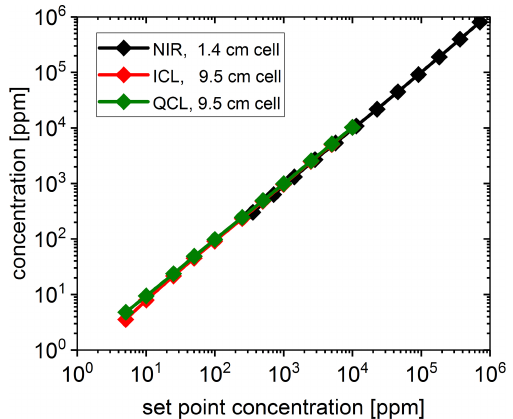
Figure 4. Results of the DAS measurements in the NIR, MWIR and LWIR spectral ranges of a series of gas mixtures of CH 4 in N 2 .